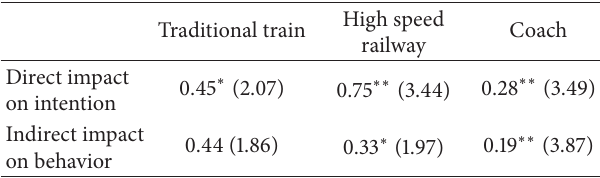
Table 5: Direct and indirect impact of DN on intention and